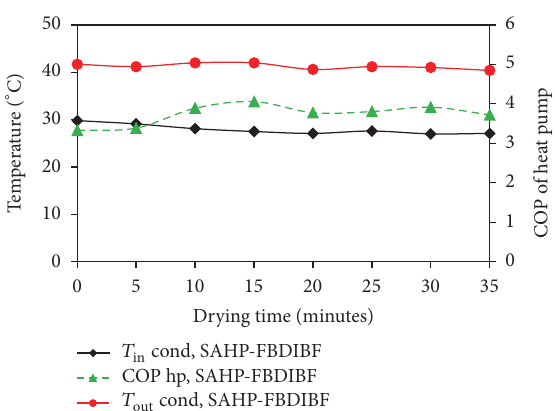
Figure 11: The variation of temperature and COP of heat pump with drying time for